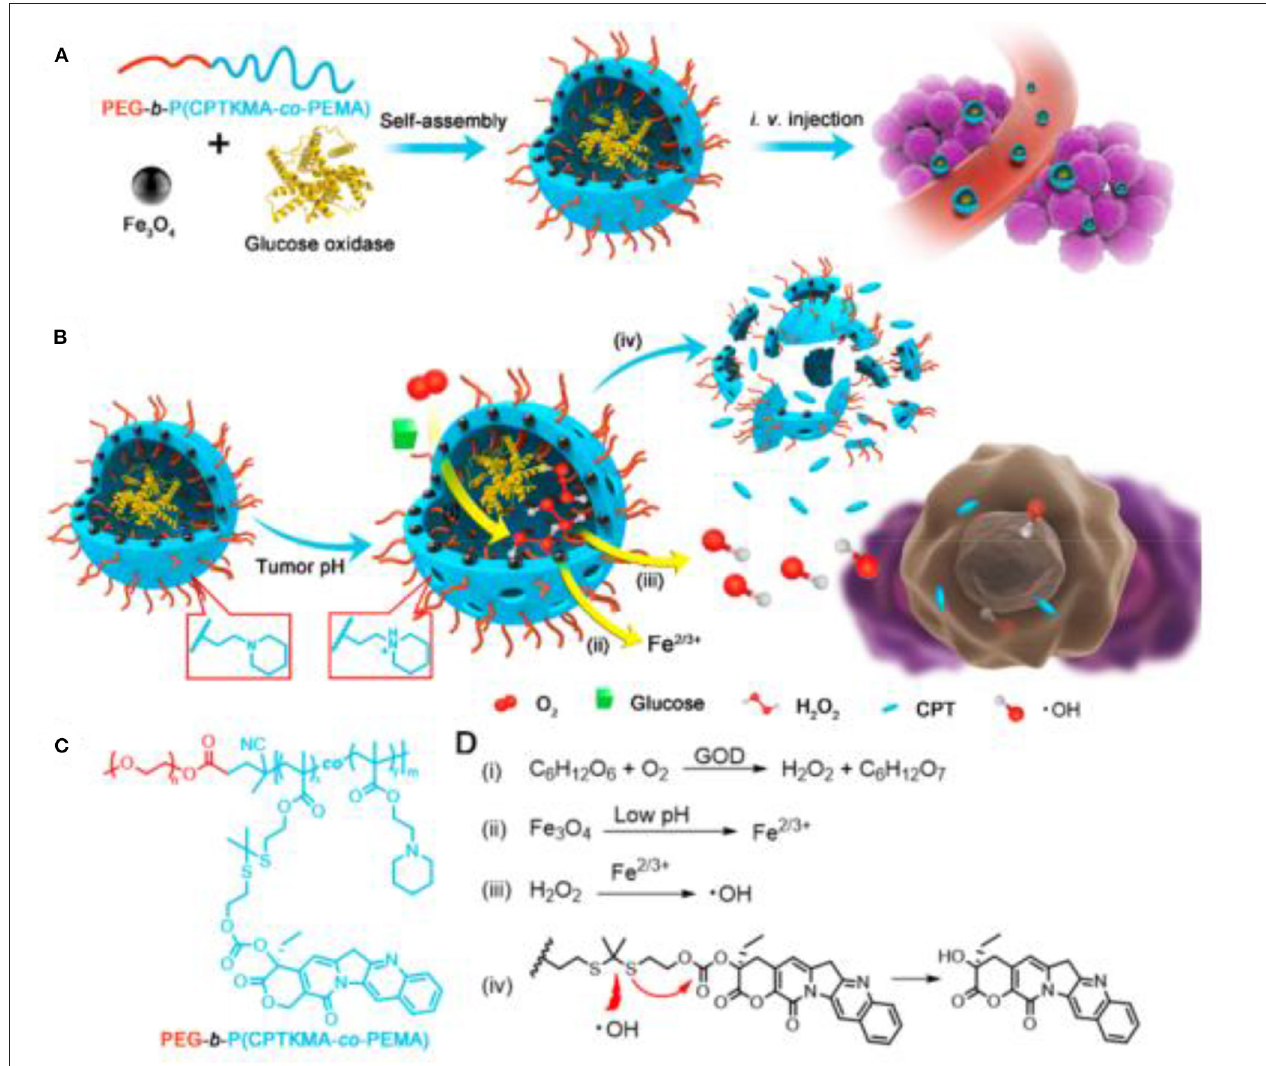
FIGURE 11 | Schematic illustration for (A) preparation of polymersome nanoreactors and (B) cascade reactions in the nanoreactors. (C) Chemical structure of PEG-b-P(CPTKMA-co-PEMA). (D) Cascade reactions equations occurring in the nanoreactors. Reproduced, with permission, from Ke et al. (2019). Copyright 2019, American Chemical